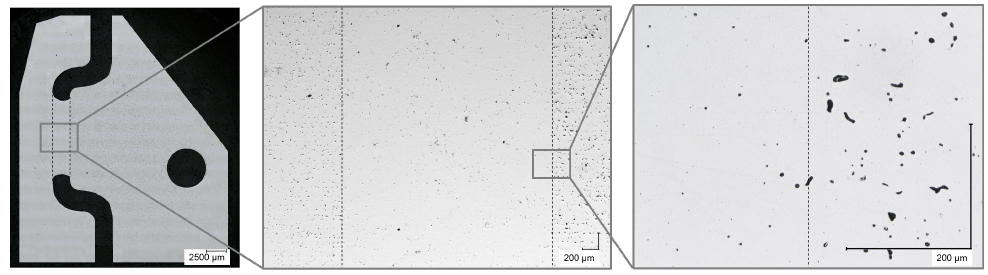
Figure 2. Clogged channel in a sintered binder jetting